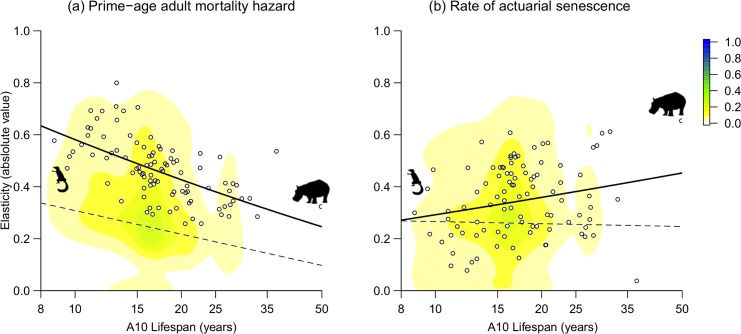
Elasticity of the life span to (a) the baseline mortality hazard and to (b) the rate of actuarial senescence. The color scale represents the distribution of elasticity by chance (see “Conformity test” in the Material and methods section). The solid lines represent the interspecific regression across observed values. The dashed lines indicate the life span–specific mode of the expected distribution by chance. The pictograms represent the lightest and heaviest species in the sample (tree shrew T. glis and hippopotamus H. amphibius). The shortest-lived, leftmost point on this graph is Saiga tatarica. The data for this figure are accessible online as S3 Data.